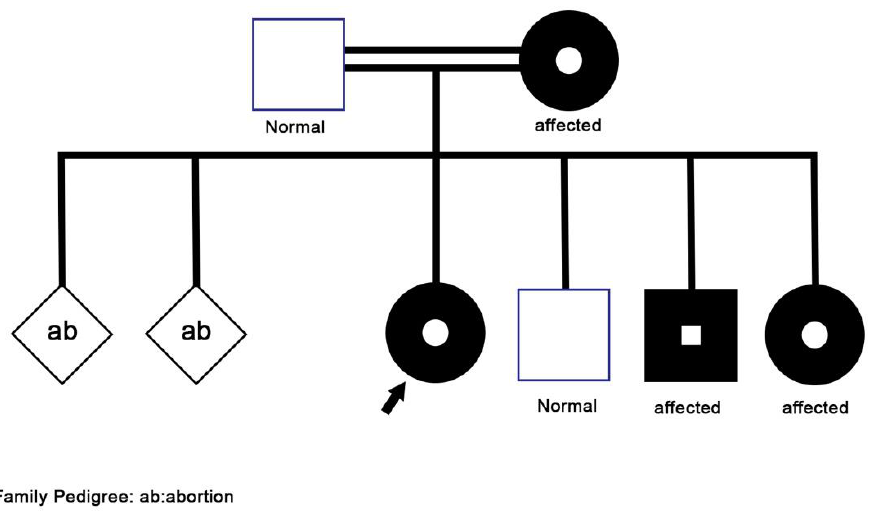
Figure 1. Family Figure 1. Family Pedigree.